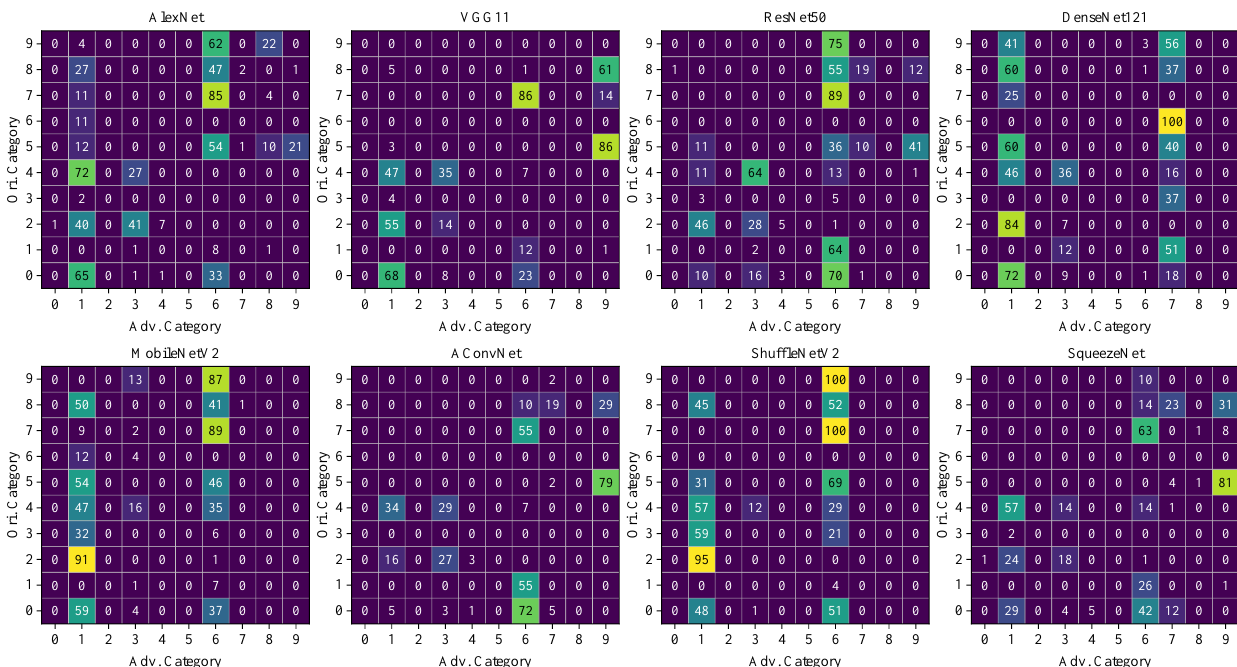
Figure 7. Distribution of adversarial label: Ori category refers to the ground truth category of targets; Adv. category denotes the misclassified category of the universal adversarial examples. The numbers from 0 to 9, respectively, indicate the following classes: 2S1, BMP2, BRDM2, BTR70, BTR60, D7, T72, T62, ZIL131, and ZSU234. Results of DF-UAP and GD-UAP can be found in Figures A1 and